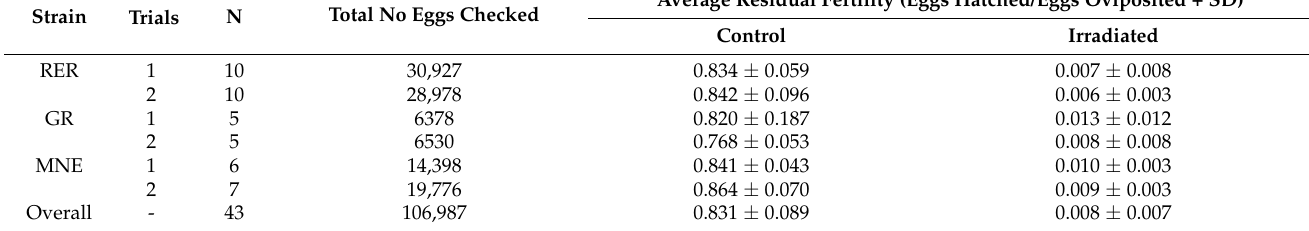
Table 1. Residual fertility (Abbott’s corrected) of eggs laid by Aedes albopictus females mated with conspecific males irradiated as pupae at 35 Gy. Strains: Greece (GR), Montenegro (MNE) and Italy